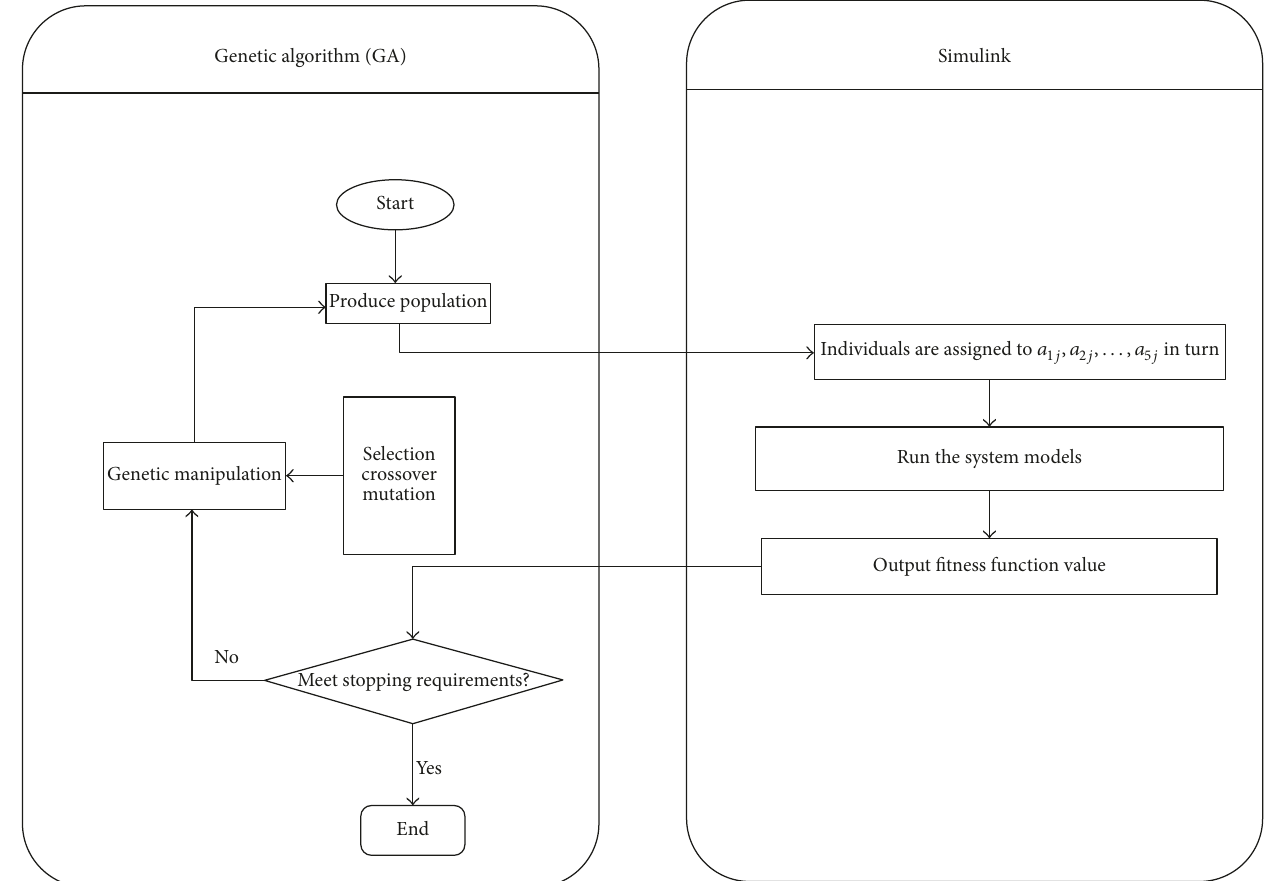
Figure 11: Flow chart of the fuzzy control optimized by